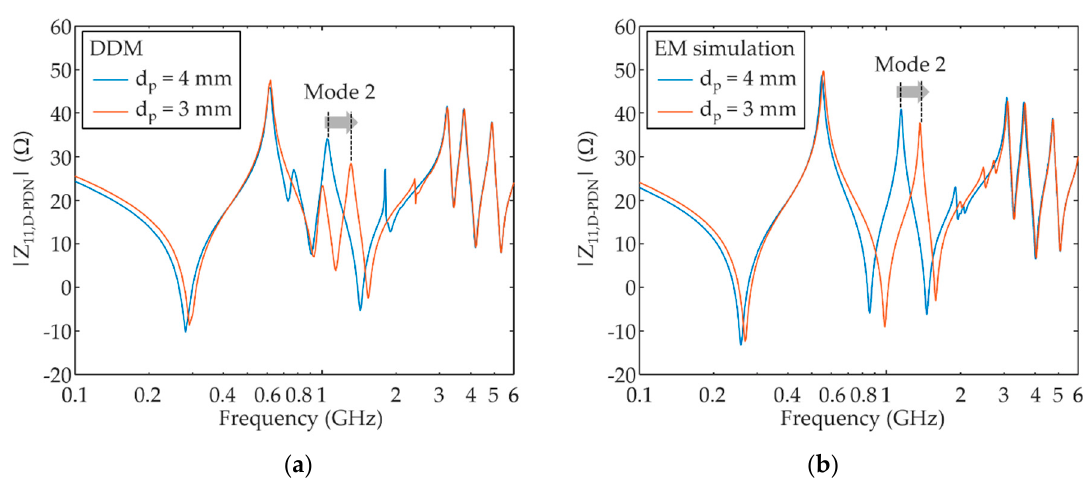
Figure 15. Self-impedances of ( a ) DDM and ( b ) EM simulation for analysis of the effect of patch size of the DGS–EBG structure on power integrity.